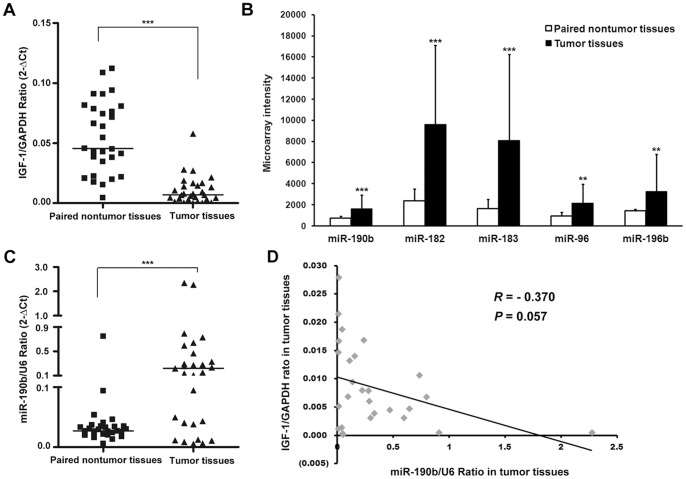
Identification of miRNA that targets IGF-1.(A) qRT-PCR analysis showing that IGF-1 expression levels were significantly down-regulated in HCC tumor tissues as compared with paired nontumor tissues. The horizontal line indicates the median. The expression level of IGF-1 was normalized by GAPDH. (B) An integrative analysis of miRNA BeadArray with TargetScan predictions defined 5 miRNAs that are up-regulated in HCC tumor tissues and could potentially bind to the 3′-UTR of IGF-1 mRNA. (C) qRT-PCR analysis of miR-190b expression in HCC tumor and nontumor tissues. The horizontal line indicates the median. The expression level of miR-190b was normalized by U6. (D) Correlation between expression levels of IGF-1 and miR-190b of tumor tissues in 29 HCC patients. Linear regression coefficients and statistical significance are indicated. ***P<0.001; **P<0.01.